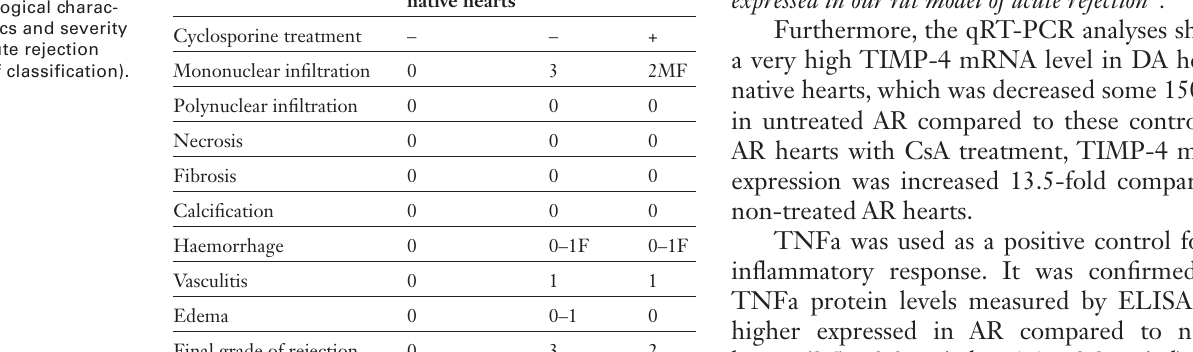
Histological charac- teristics and severity of acute rejection (Banff classification).